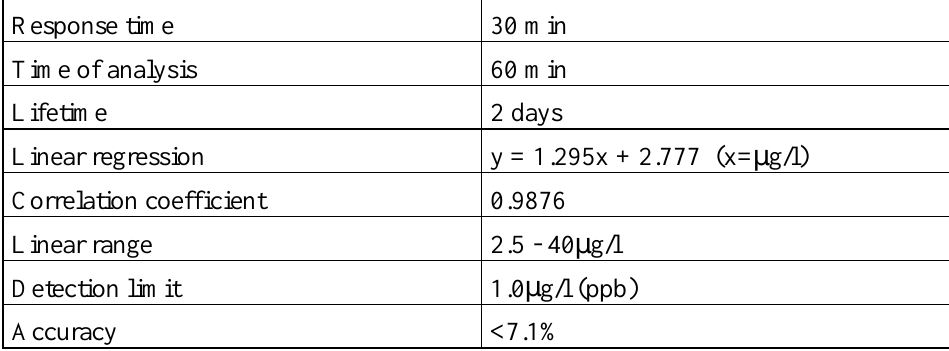
Table 2 (b). Analytical features obtained for paraoxon with an enzymatic